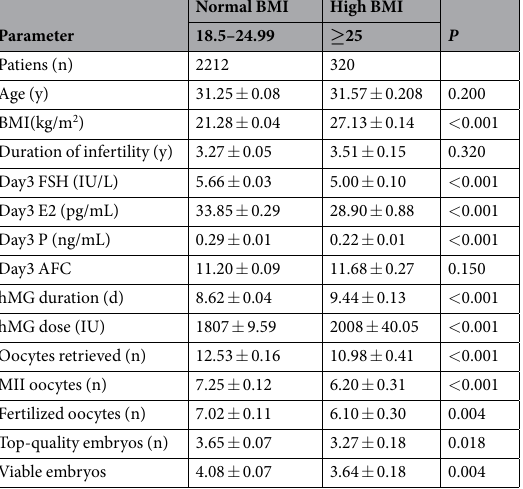
Table 1. Clinical characteristics and oocytes outcomes under the frozen-thawed embryo transfer technology according to female BMIs. Student’s t -tests or Mann-Whitney U -test were applied. Data are presented as mean ± standard error of the mean. The differences were considered statistically significant when the p-value was less than